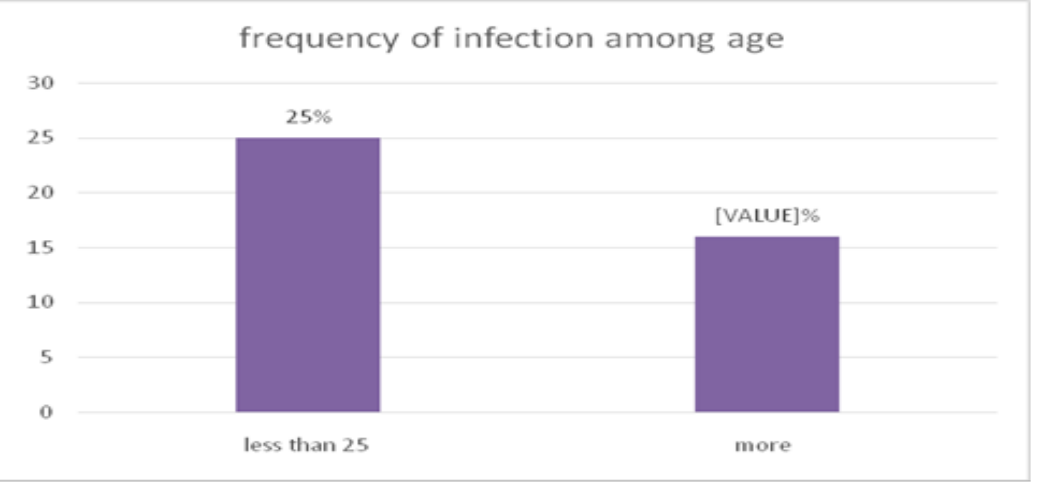
Figure 4. Frequency of infection among age